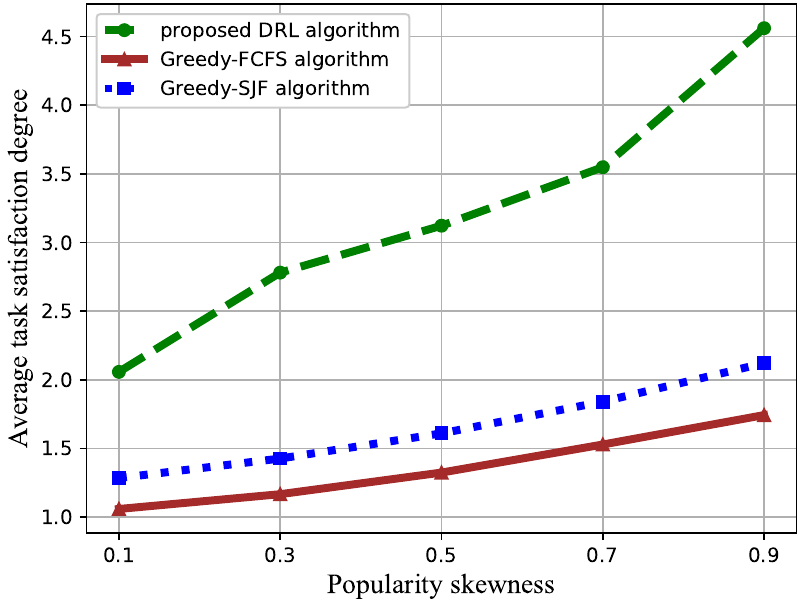
Figure 10. Average task satisfaction degree versus the popularity skewness.